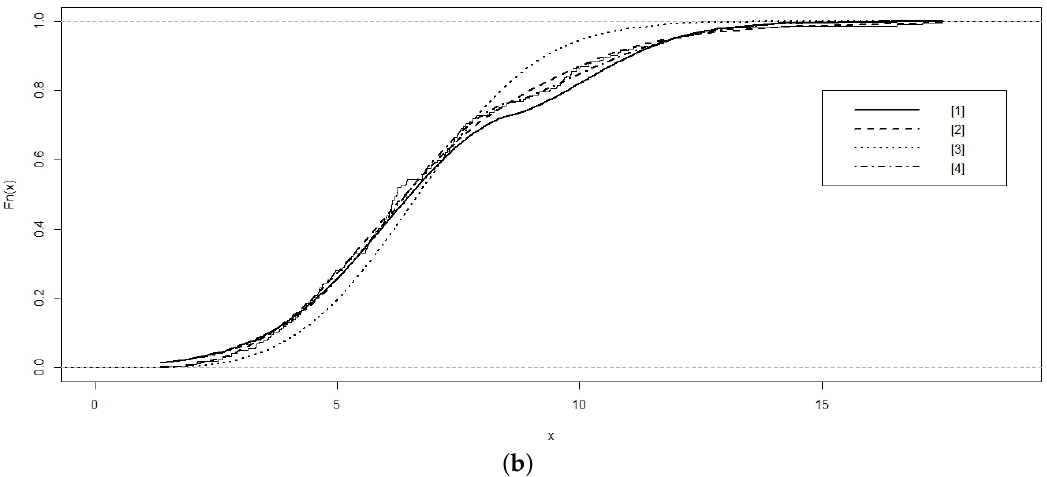
Figure 7. Health data - Fitted distributions. [1] Skew GL-Normal distribution; [2] Skew GL- t distribution; [3] Skew Normal-GL distribution; [4] Skew t -GL distribution. ( a ) Probability density function; ( b ) Cumulative distribution.